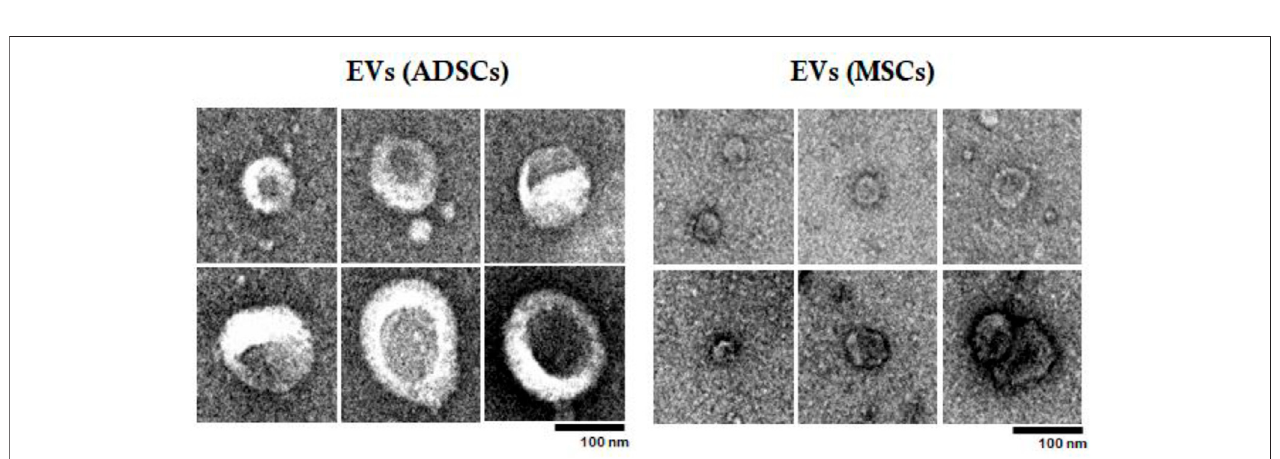
FIGURE 4 | Examination of EVs (ADSCs) and EVs (MSCs) by transmission electron microscopy (TEM). EVs were collected from the secretome of healthy hamster adipose tissue-derived stem cells (ADSCs) or of bone marrow-derived stem cells (BM-MSCs). The effect of atherogenic diet and treatment on main plasma parameters were